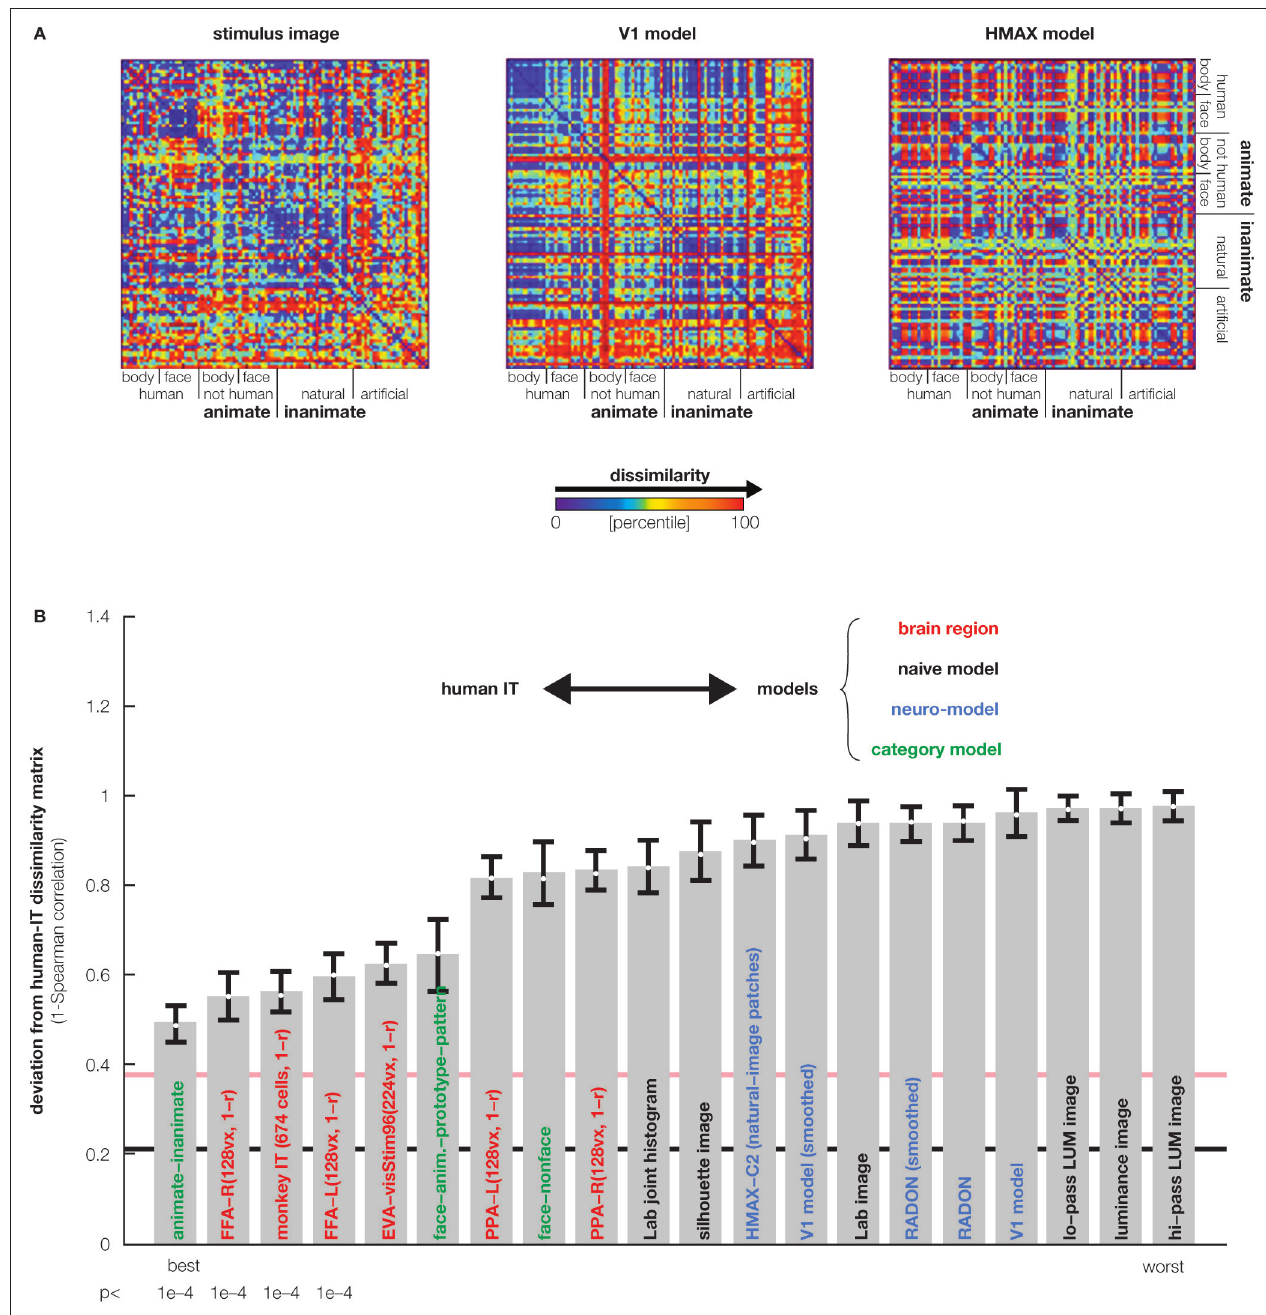
the standard error of the deviation estimate (from bootstrap resampling). The number below each bar indicates the p value for a test of relatedness between the RDM of human IT and that of the model or other region. The black line indicates the noise floor, i.e., the expected deviation between the empirical reference RDM (with noise) and the underlying true RDM (without noise). The light red line indicates the expected retest deviation between the RDM for human IT that would be expected if the experiment were repeated with different subjects (both matrices affected by noise). This analysis has not previously been published, but the method follows Kriegeskorte et al.